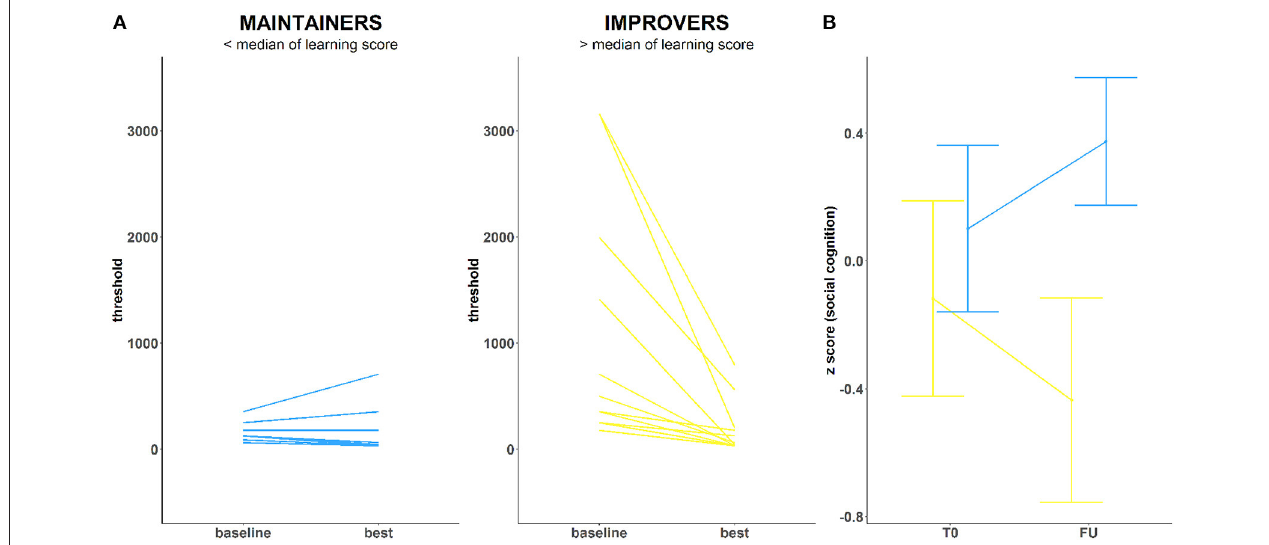
FIGURE 1 | (A) Training performance in two ROP groups: Maintainers (left) and Improvers (right) (B) Emotion Recognition (DANVA) change over the course of training in both